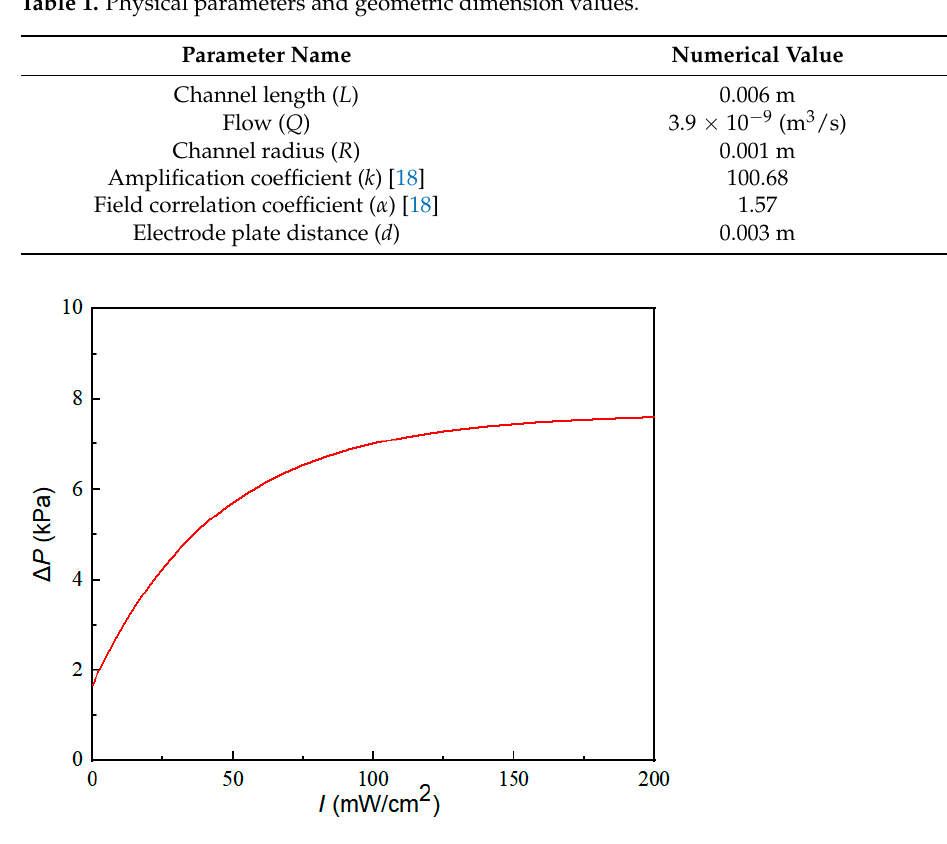
Figure 10. The relationship between the pressure difference at both ends of the microchannel and light intensity.